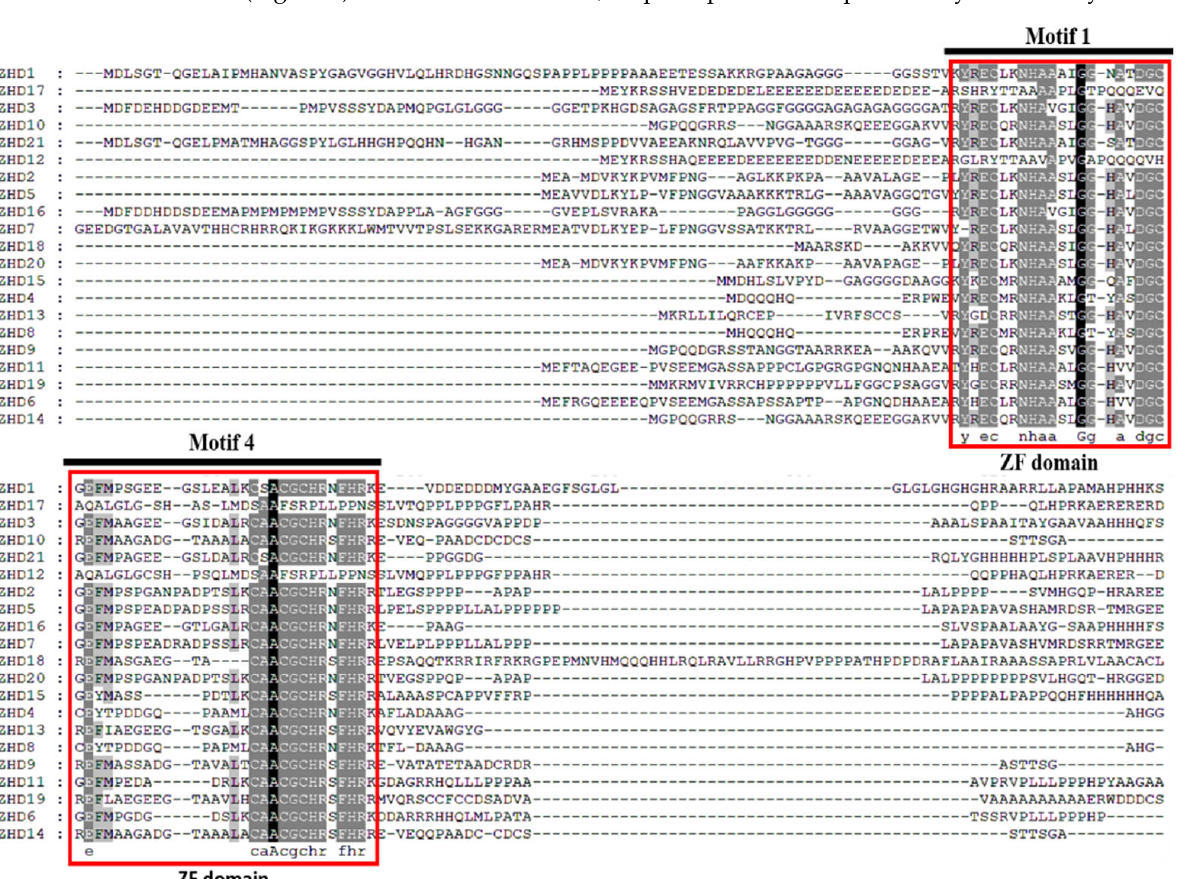
Figure 2. Phylogenetic analysis of full ‐ length ZHD protein sequences from Z. mays (Zm, maize), Arabidopsis thaliana (At, Arabidopsis ), Oryzasativa (Os, rice), Sorghum bicholor (Sb, sorghum), Brachy ‐ podiumdistachyon (Bd, purple false brome), and Dichantheliumoligosanthes (Do, Heller’s rosette grass). Red circles, red checkmarks, and red triangle, red rectangular, and red stars indicate Ara ‐ bidopsis , and rice sequences, maize respectively.